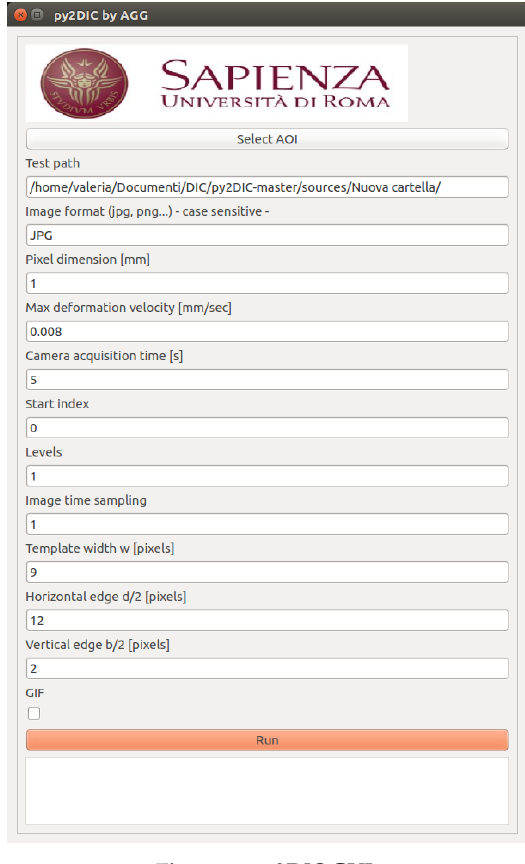
Figure 1. py2DIC